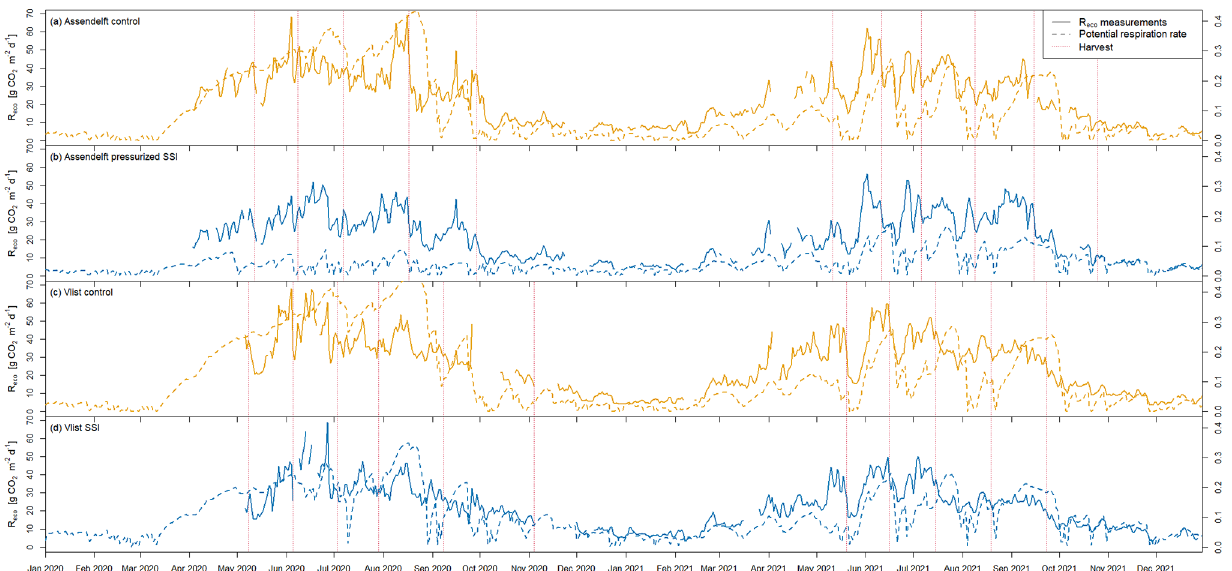
Figure 6. Measured nocturnal R eco and simulated respiration rate (secondary axis) over time for (a) Assendelft control, (b) Assendelft pressurized SSI, (c) Vlist control and (d) Vlist